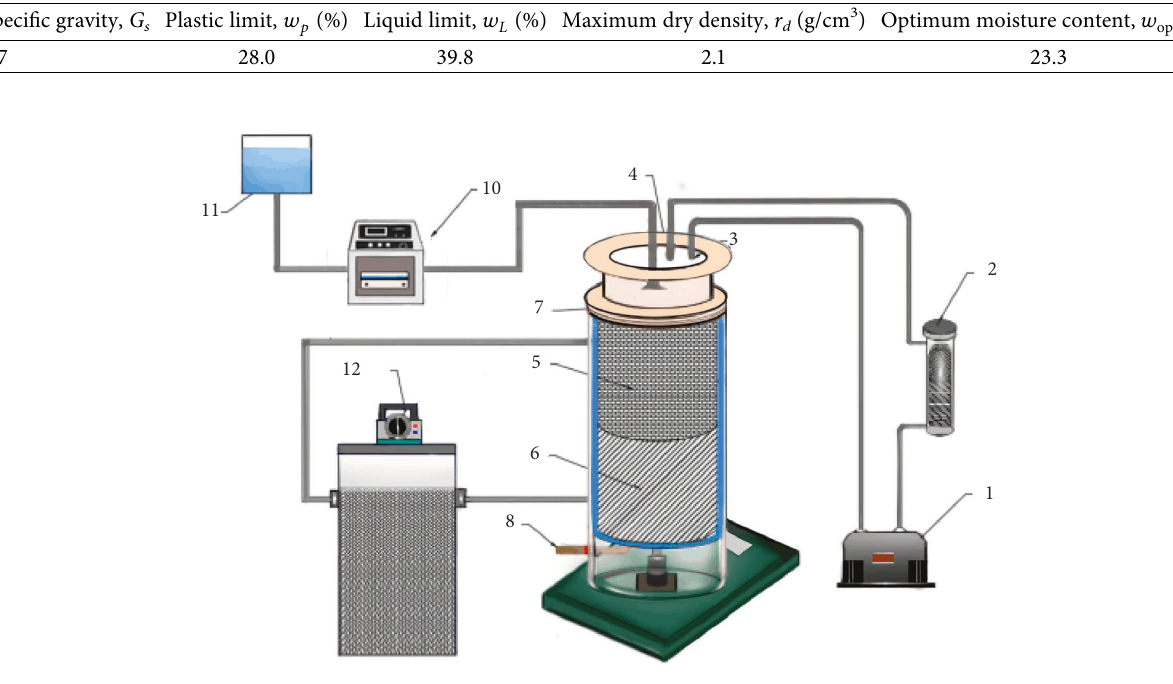
Table 2: Physical properties of the tested soil.